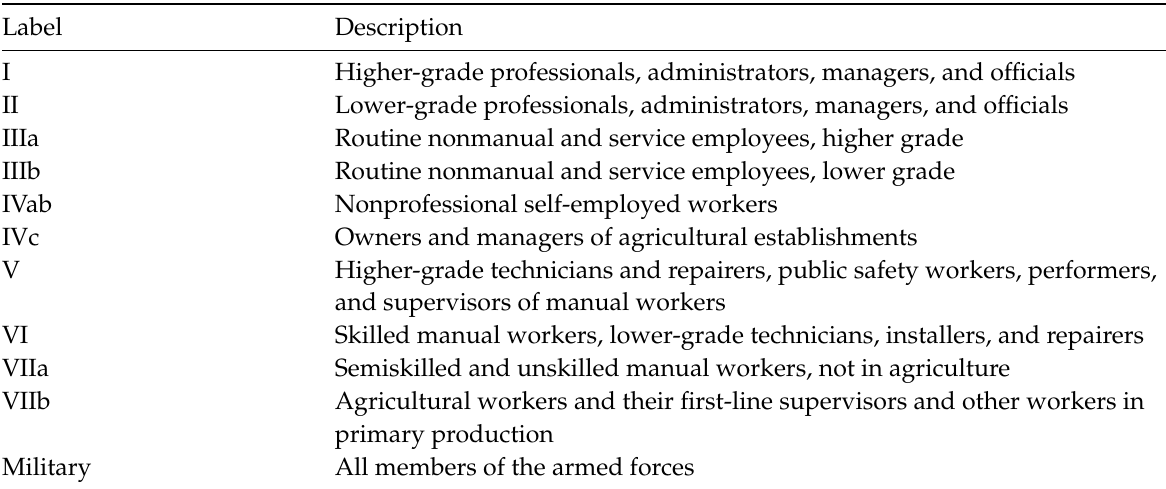
Table 1: EGP class